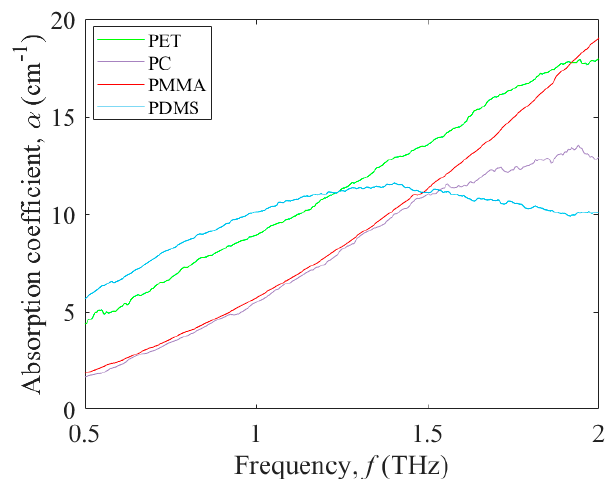
Figure 2. Terahertz absorption coefficient, α , versus frequency, f , from 0.5 to 2.0 THz for the polar polymers: PET (green curve), PC (purple curve), PMMA (red curve), and PDMS (blue curve).